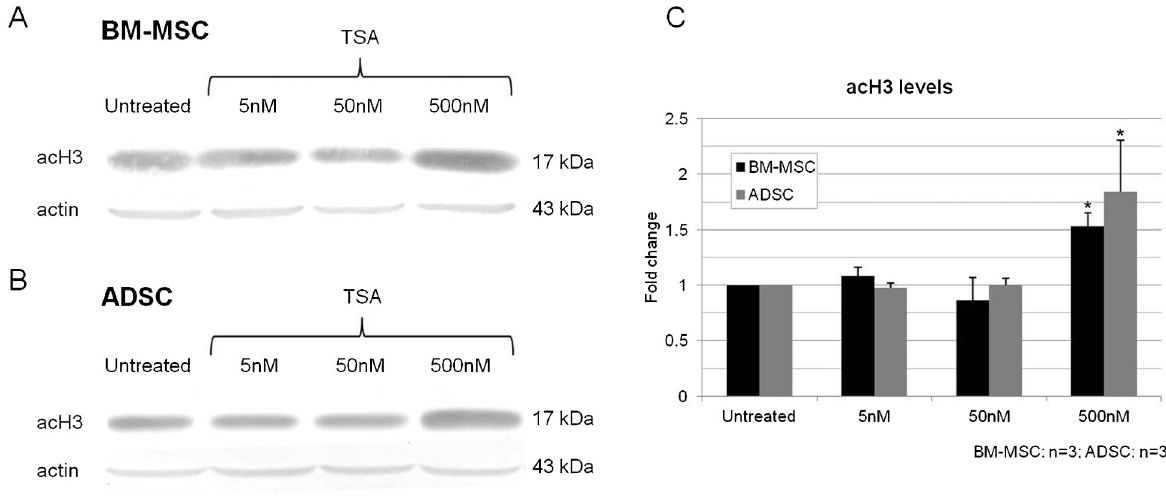
Figure 2. Analysis of histone acetylation in MSCs after 2 days of treatment with TSA (5, 50 and 500 nM). A , B , Western blot analysis of acH3 levels in cultured BM-MSCs ( A ) and ADSCs ( B ); an actin probe was used as a loading control. C , Quantitative analysis of relative levels of acH3 in cultured BM-MSCs and ADSCs. MSCs = mesenchymal stem cells; TSA = trichostatin A; BM-MSCs = bone marrow MSCs; ADSCs = adipose tissue stem cells. Data are reported as means ± SD. Asterisks just above SD bars indicate a statistically significant difference with respect to untreated cultures of BM-MSCs or ADSCs. *P , 0.05 (Student t -test).